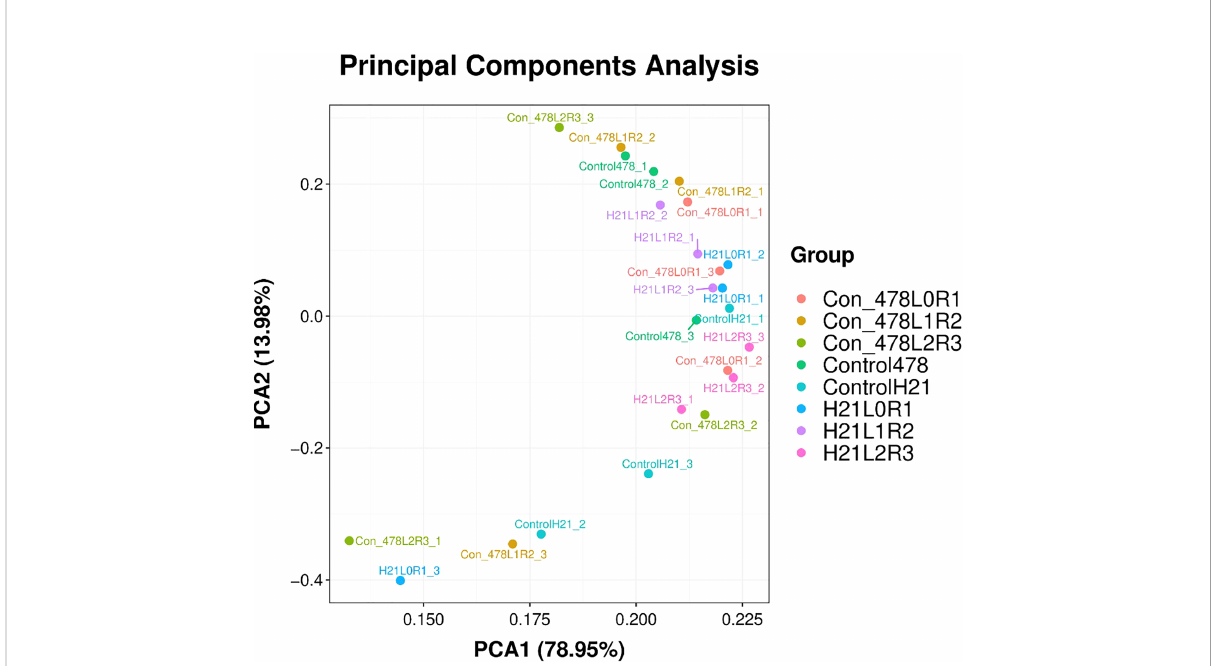
FIGURE 8 Categorization of different maize genotypes for drought tolerance and sensitivity. PCA with 78.95% values on the x-axis and 13.98% values on the y-axis.